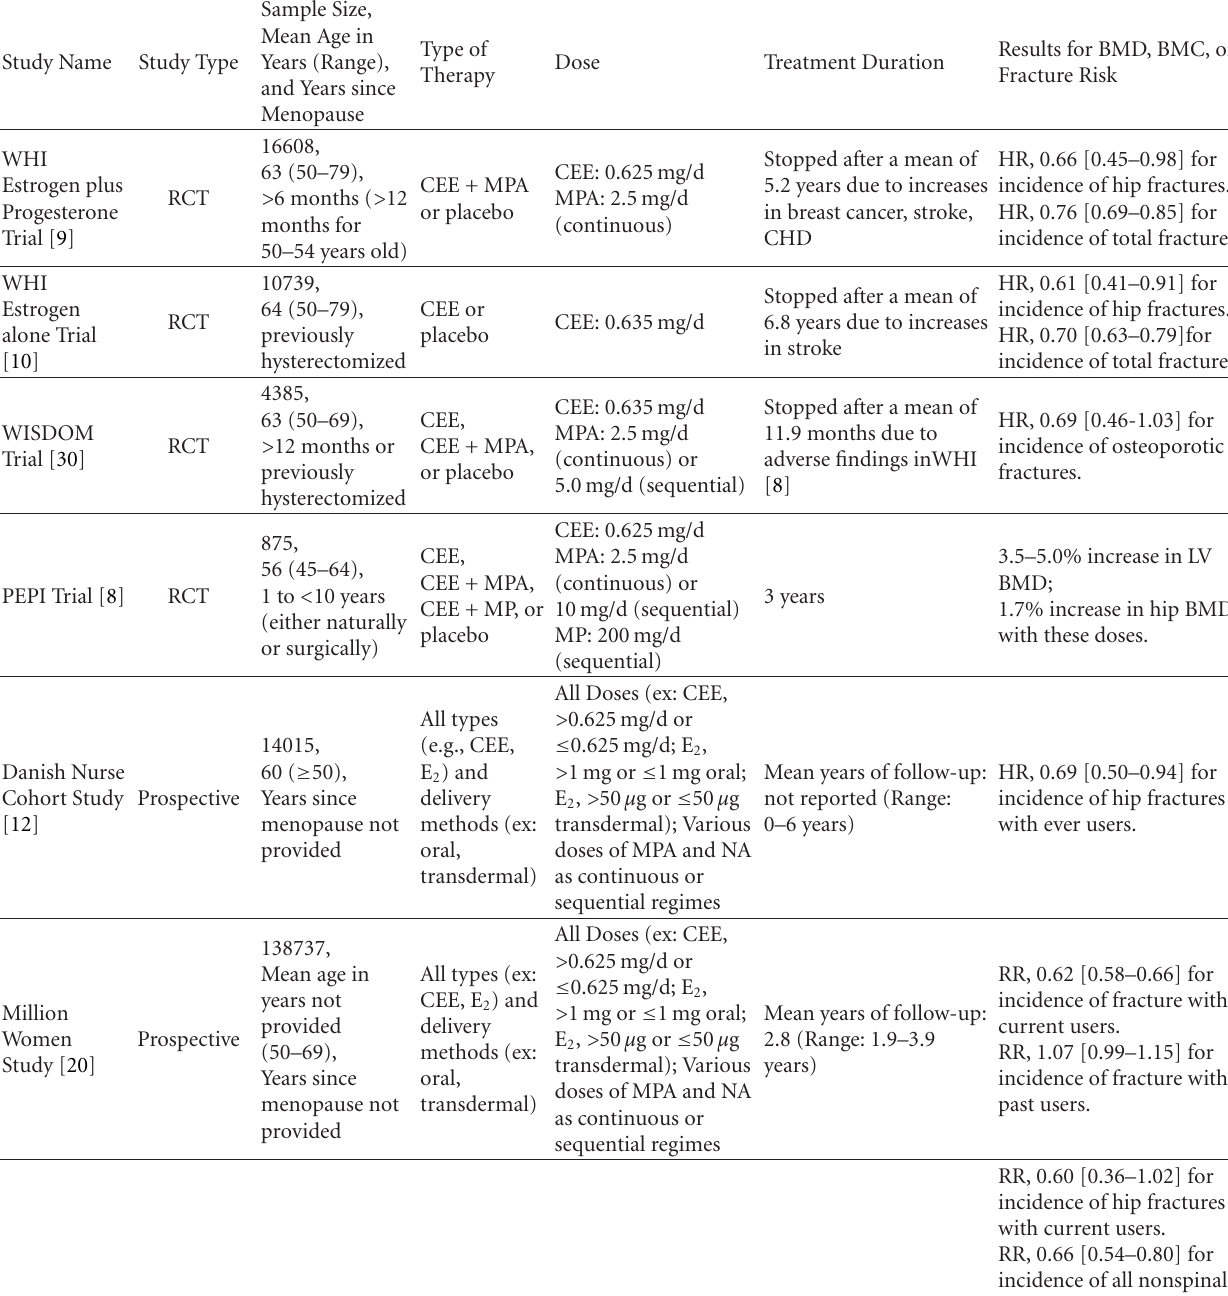
Table 1: Selected studies on the e ff ect of hormone therapy on bone metabolism in postmenopausal